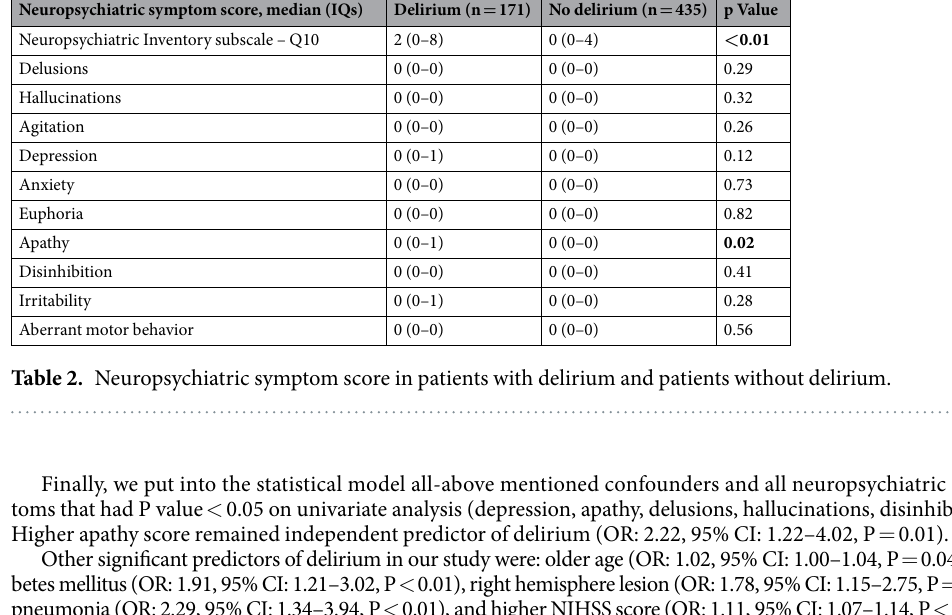
Data about pre-stroke medications were available for 536 patients (Table S1 in supplementary file). Exclusion of patients who took anti-depressants (N = 18), neuroleptics (N = 7) or benzodiazepines (N = 12)